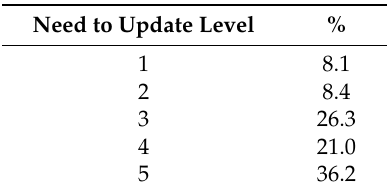
Table 10. Need to Update levels according to users of DEMs.